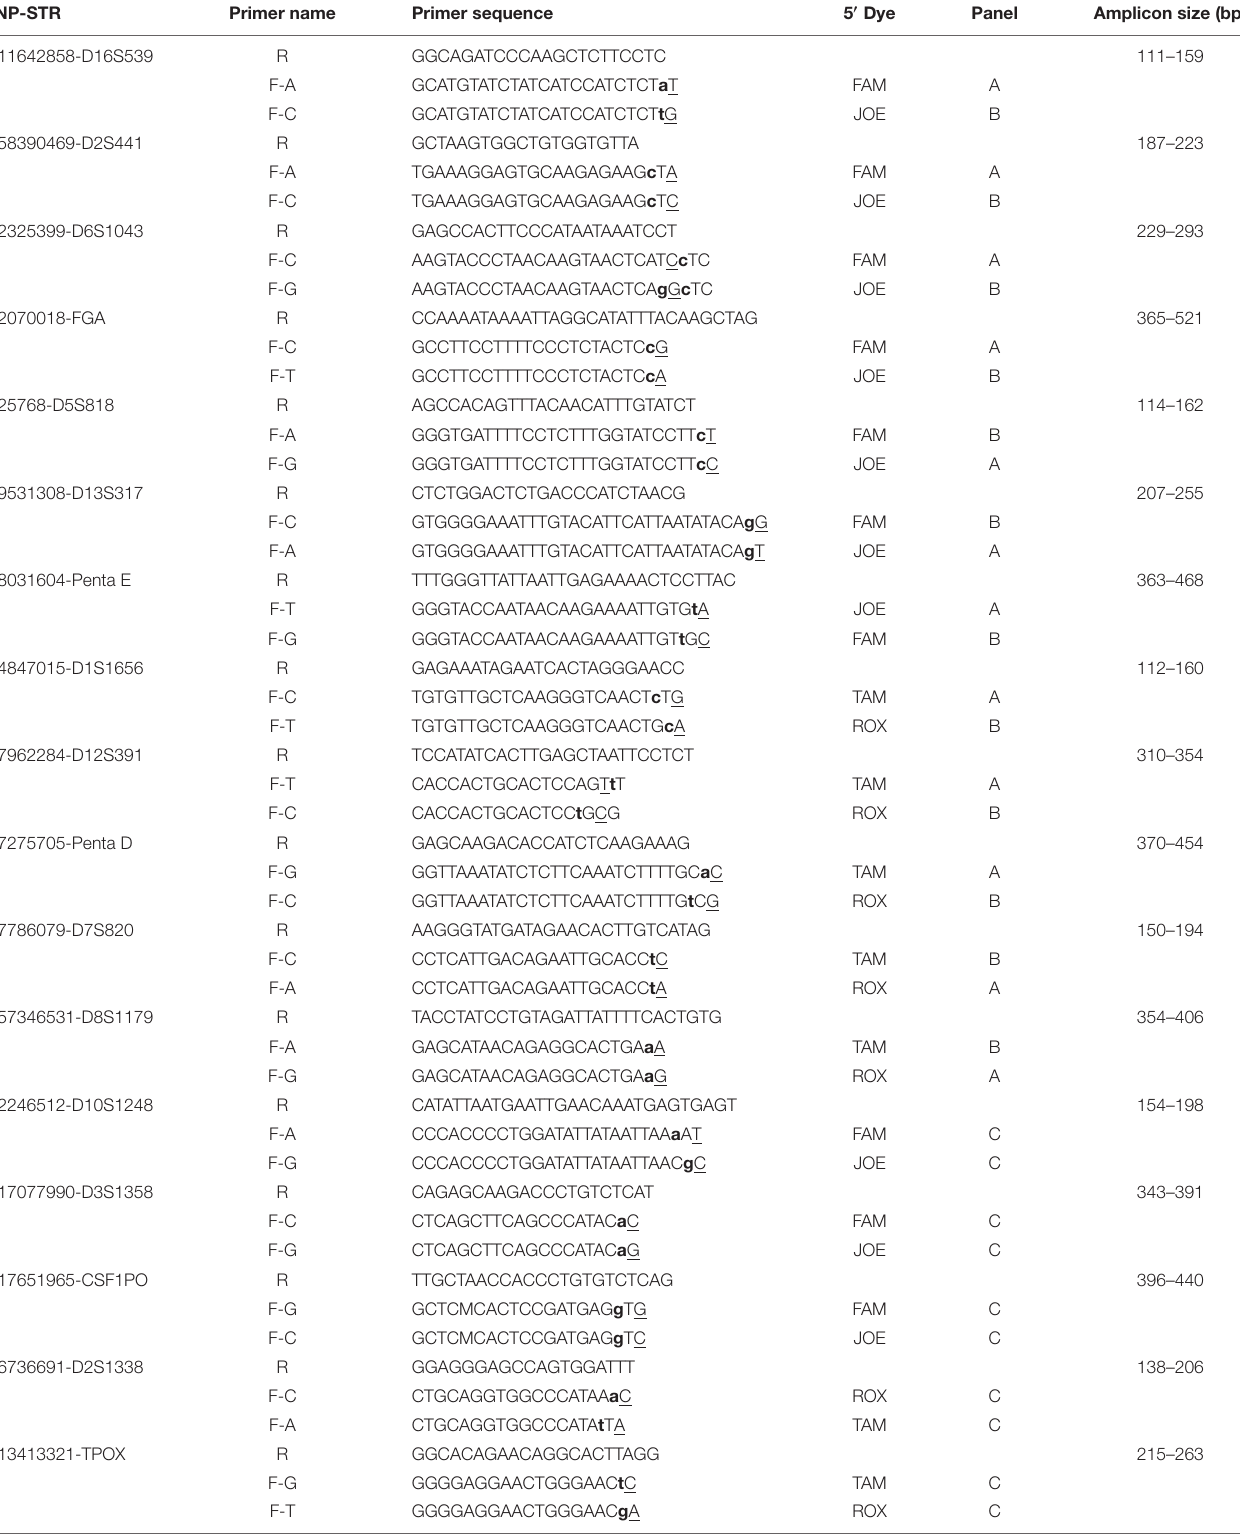
TABLE 2 | Primer list of 19